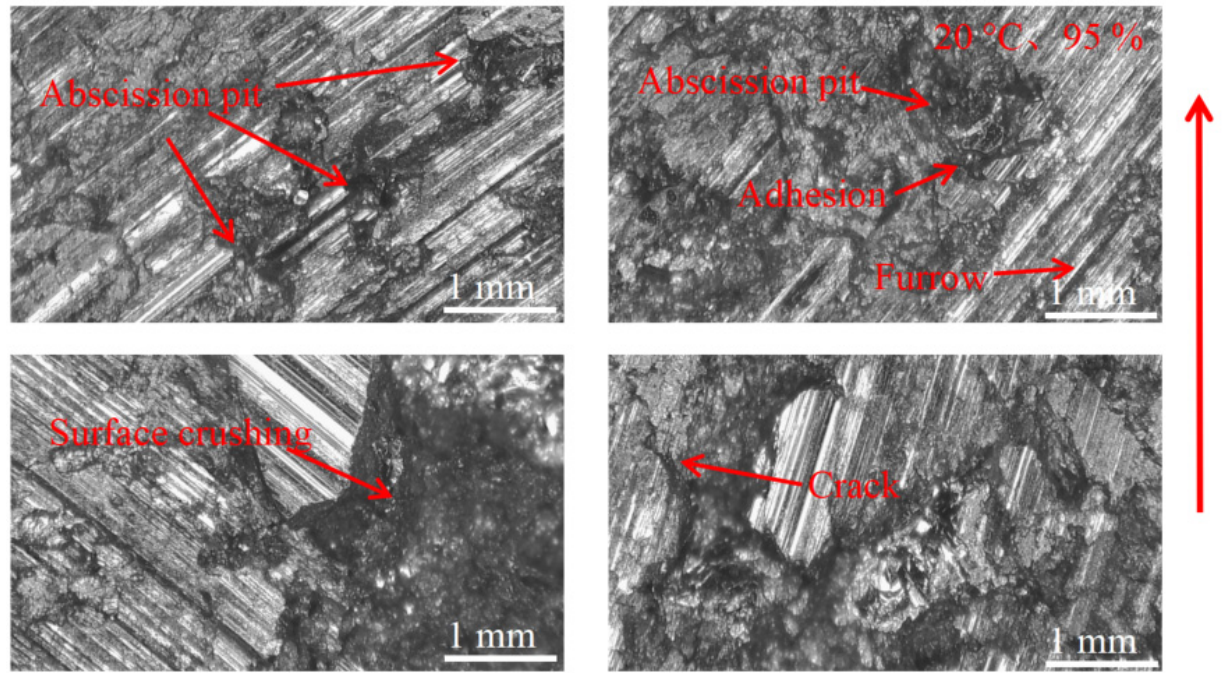
Figure 21. Surface morphology damage map of brake pad at 20 °C and 95% ambient humidity.